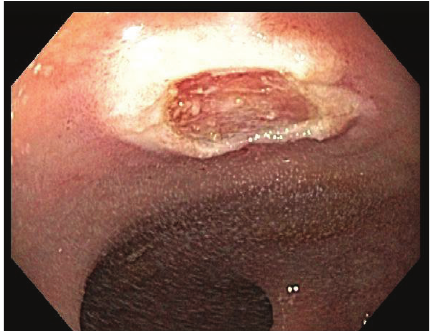
Figure 1: Rectal nodule on initial endoscopic examination.